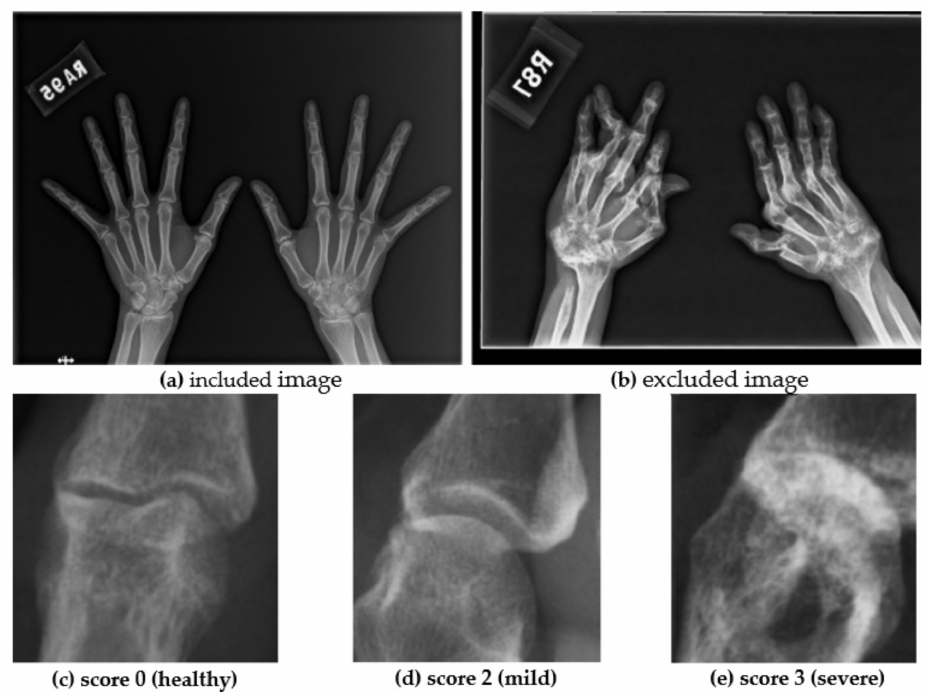
Figure 1. Comparison of examples of normal X-rays and RA images: ( a ) normal image; ( b ) image filtered out because of distortion; ( c ) healthy joint; ( d ) mild joint; ( e ) severe